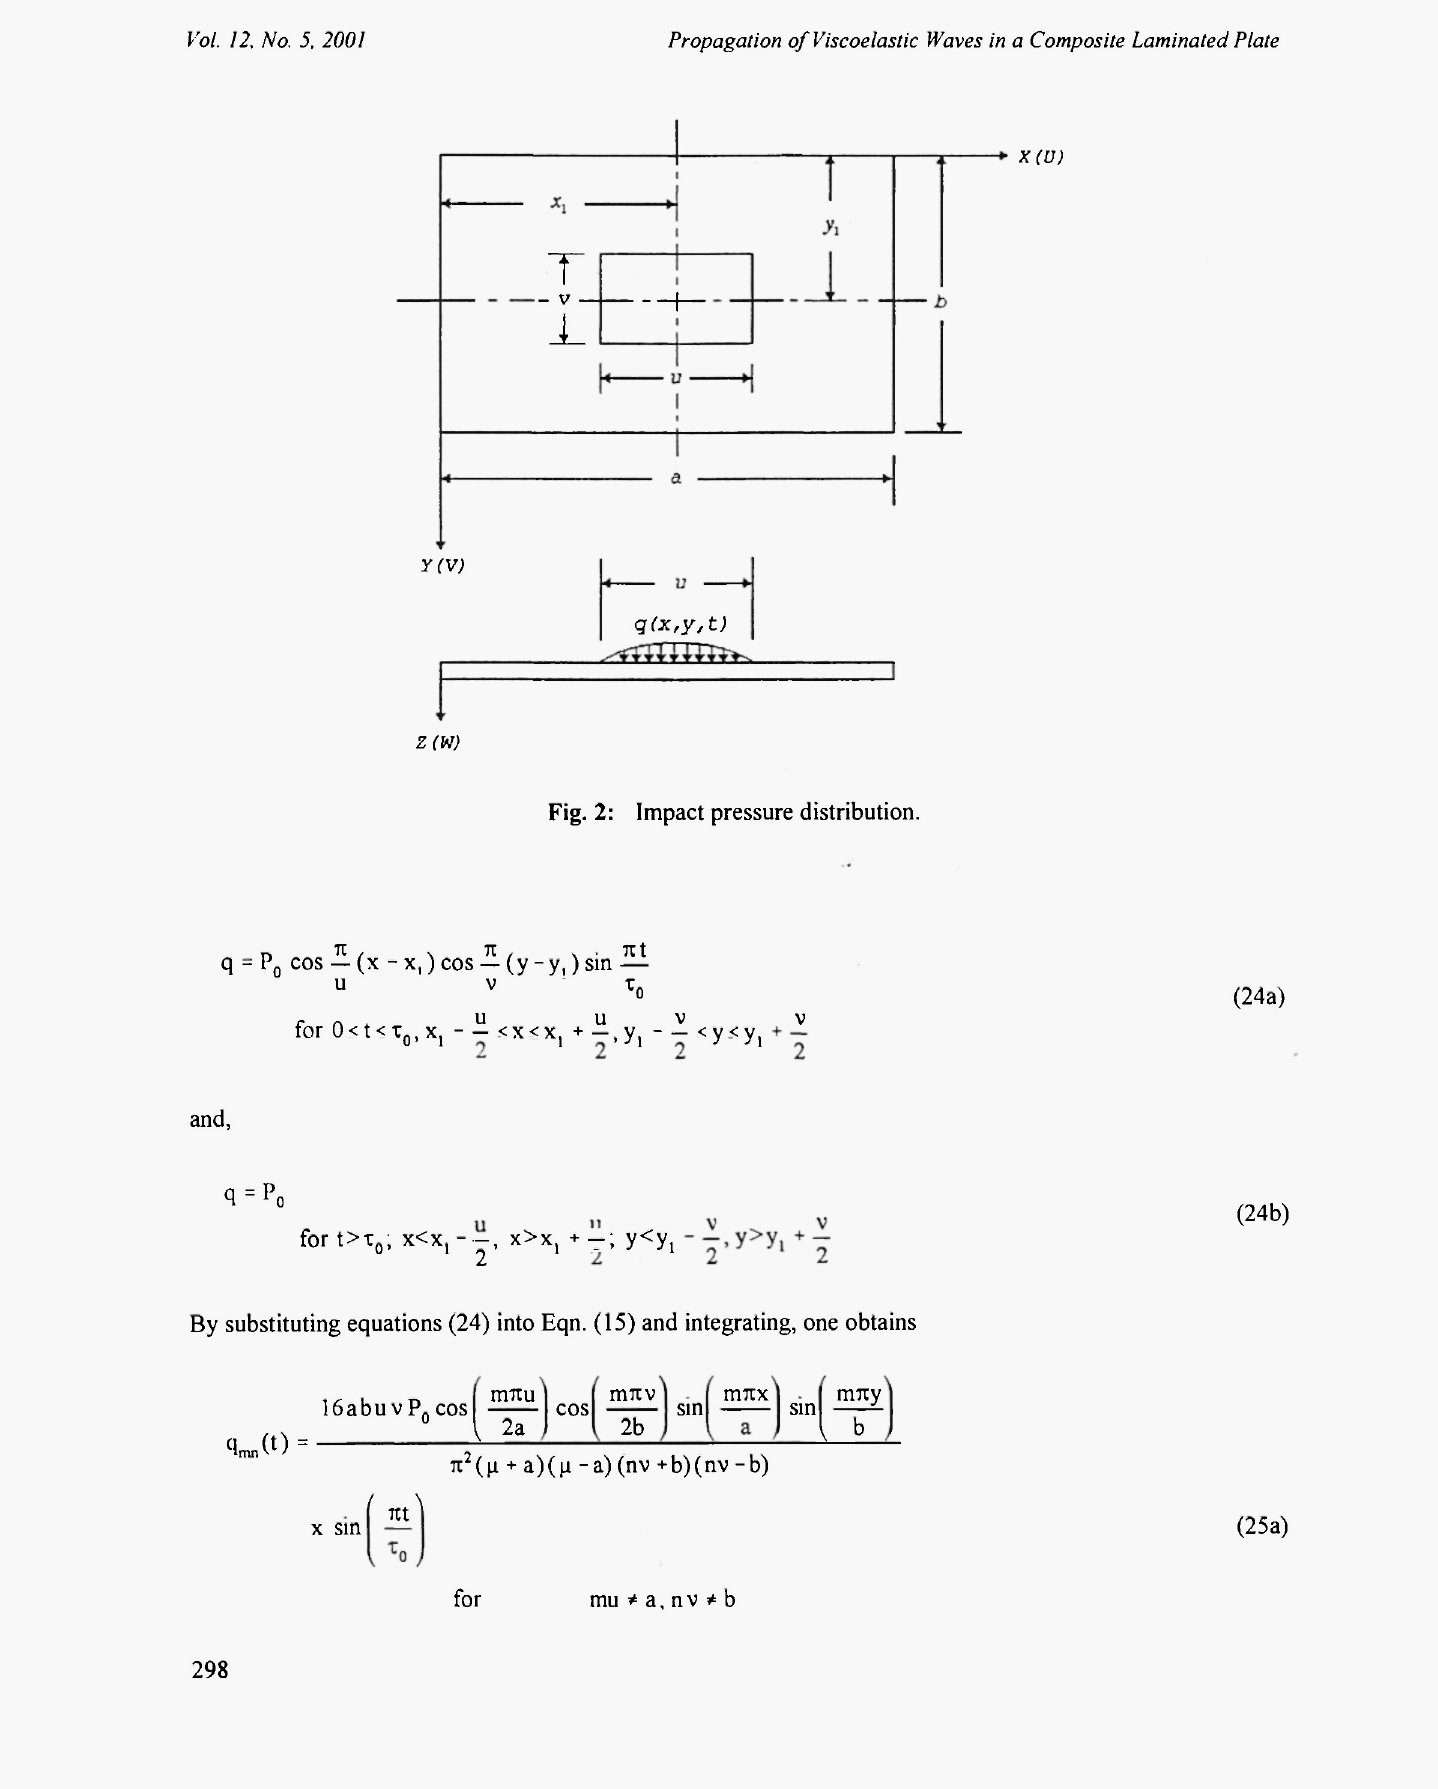
Fig. 2: Impact pressure